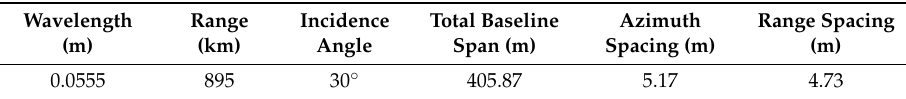
Table 1. RADARSAT-2 SAR parameters.